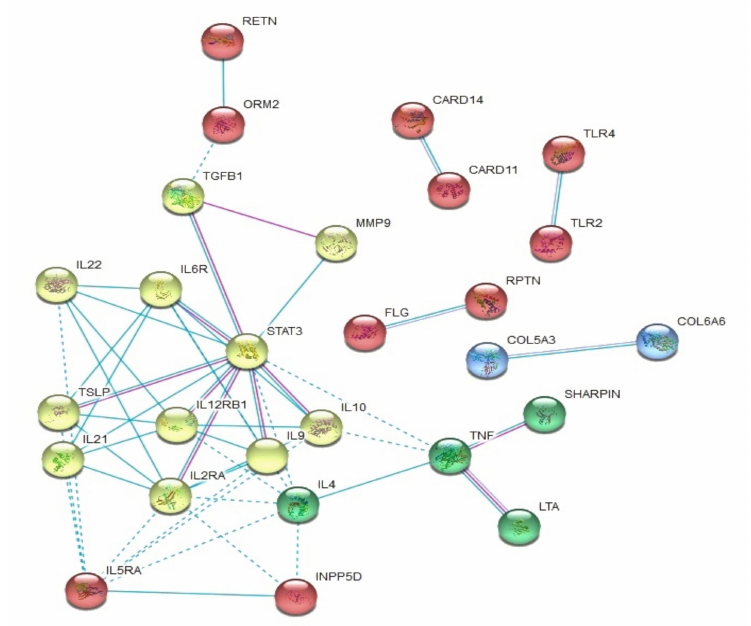
Figure 3. Functional association protein networks in STRING software (STRING consortium: Swiss Institute of Bioinformatics, Lausanne, Switzerland; Novo Nordisk Foundation CPR, Copenhagen, Denmark; EMBL Heidelberg, Germany) established from the genes reported in the selected studies. The diverse clusters are colored di ff erently. Protein–protein interactions are drawn in blue, when obtained from curated databases, or purple if experimentally determined. Inter-cluster edges are represented by